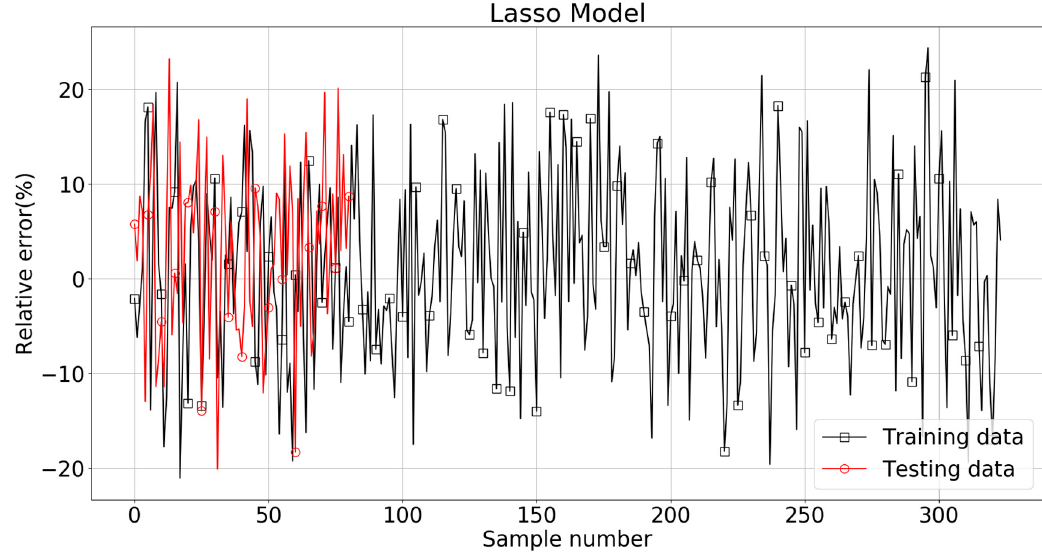
Figure 15. Variation of the relative errors obtained from the Lasso model.